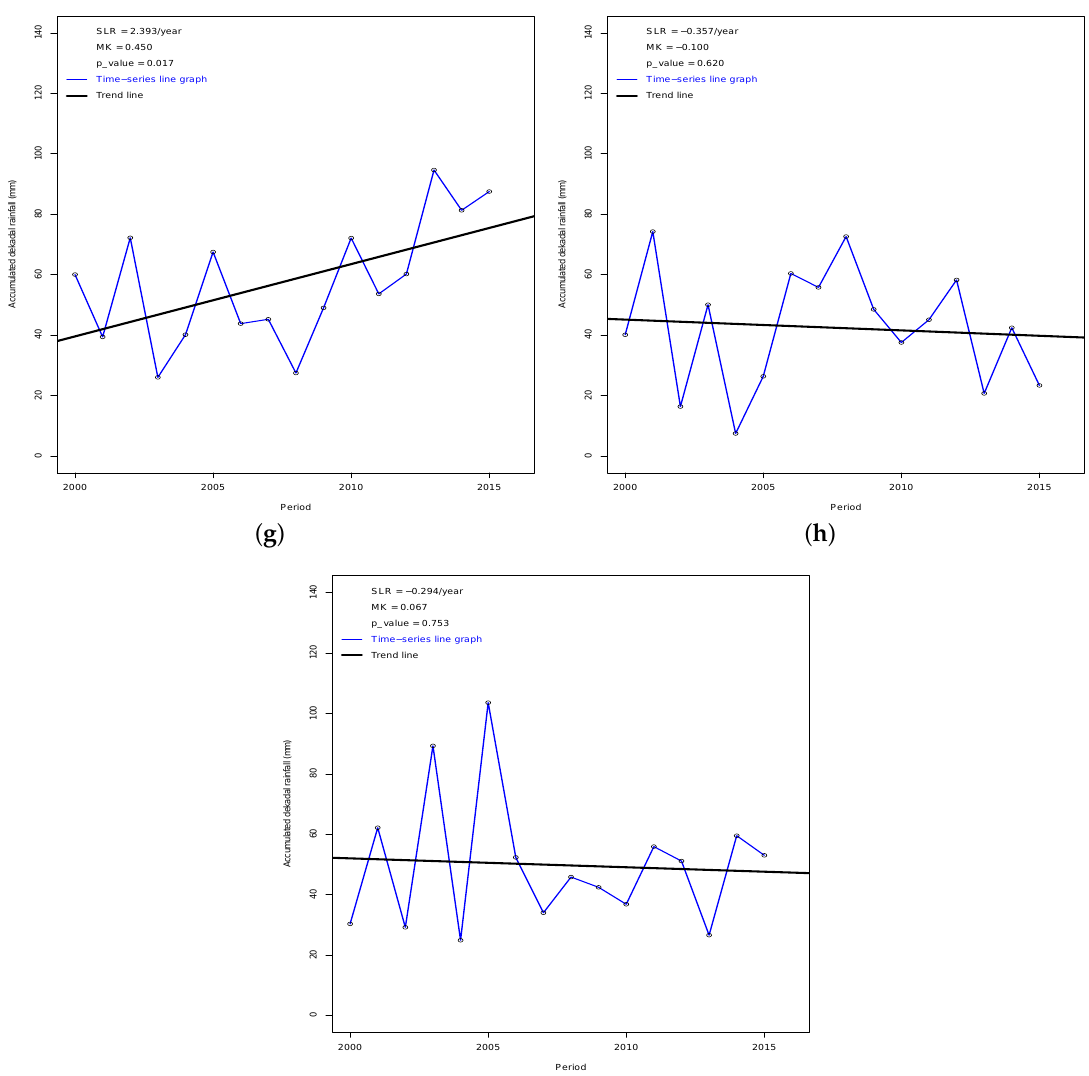
Figure 6. The figure is for accumulated dekadal rainfall averaged over the study locations. The vertical axis represents average dekadal rainfall for a given dekad, and we have used same scale for the ease of comparison. The rate of decrease/increase of the average dekadal rainfall; the Mann–Kendall trend along with its significant level is presented along with each subfigure ( a – i ). “dk” means dekad. ( a ) First dekad rainfall; ( b ) second dkrainfall; ( c ) third dk rainfall; ( d ) fourth dk rainfall; ( e ) fifth dk rainfall;